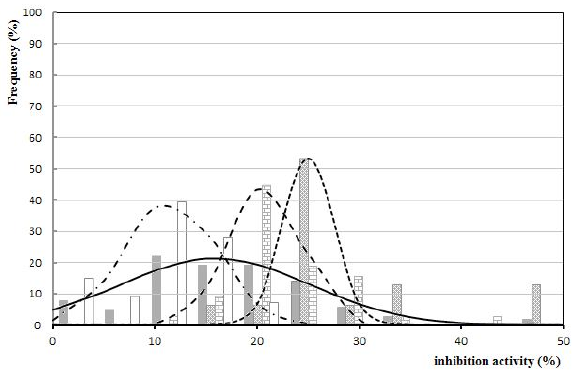
Figure 10: Distribution of thrombin inhibitory activity of oat extracts expressed as % of inhibitory activity (solid column and solid line – complete set, r 2 = 0.886, bracket column and dash line – minor red subset, r 2 = 0.835, dots column and dash-and-dot line – major green subset, r 2 = 0.865, empty column and dots line – major blue subset, r 2 = 0.885, the mentioned colors correspond to the colors in Fig. 7 and Fig. 8).